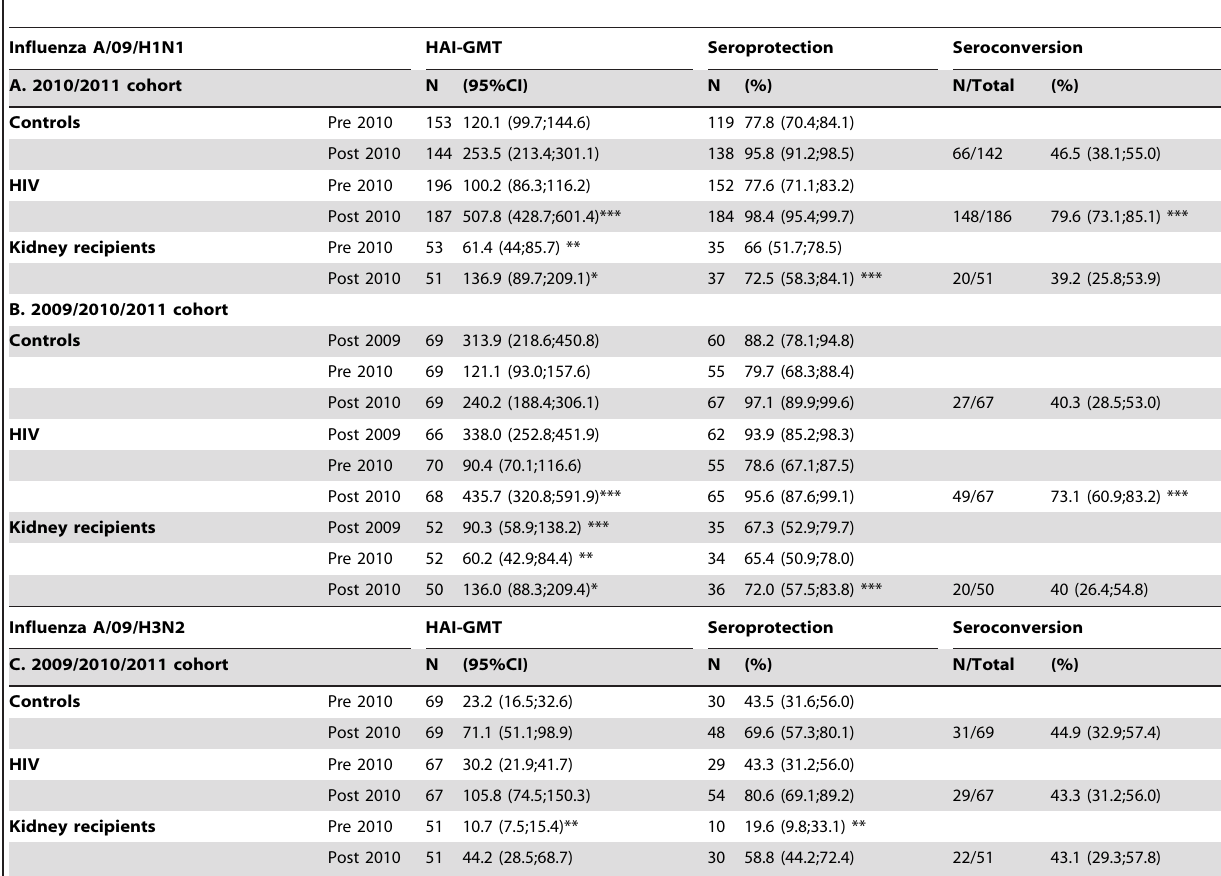
Table 2. Antibody persistence and memory responses to influenza A/09/H1N1 and A/09/H3N2.